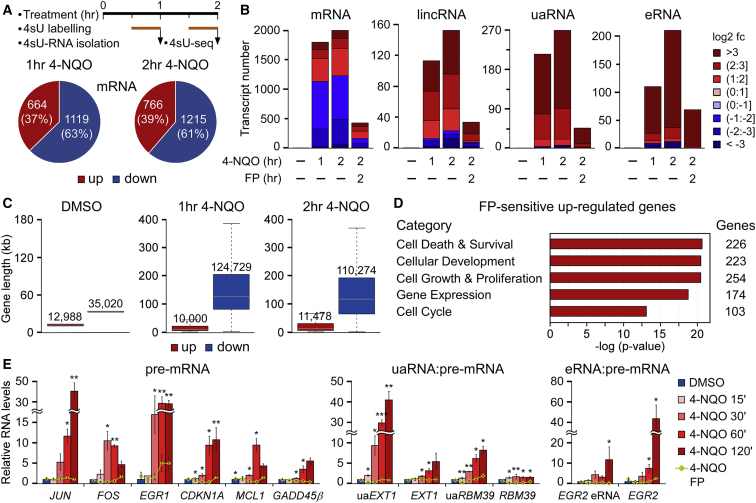
Active P-TEFb Is Vital for the Pol II Transcriptional Response to Genotoxic Stress(A) (Top) Schematic depicting major steps in the generation of 4sU-labeled transcripts (4sU RNA) for 4sU-seq. (Bottom) Pie charts showing the fractions of DE protein-coding genes (mRNA) in 4-NQO-treated HeLa cells as assessed by 4sU-seq (n = 2).(B) Bar charts showing the number of DE classes of transcripts in HeLa cells as assessed by 4sU-seq (n = 2). The degrees of differential expression are presented according to the legend. Conditions with (in hours) and without (−) 4-NQO or FP are shown.(C) Boxplots indicating the distribution of gene lengths for upregulated and downregulated protein-coding genes. Median gene length for each group is shown.(D) Top Molecular and Cellular Functions categories of the 4FP gene set as identified by IPA. The number of affected genes per category is shown on the right.(E) RT-qPCR of the indicated DNA damage-induced unspliced (pre-mRNA), uaRNA, and eRNA transcripts. HeLa cells were treated as indicated by the legend. Results were normalized to the DMSO control and are presented as the mean ± SEM (n = 3). ∗p < 0.05; ∗∗p < 0.01; ∗∗∗p < 0.001, determined by Student’s t test.See also Figure S4 and Tables S3A–S3G.